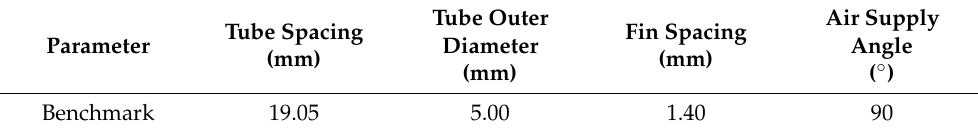
Table 7. Benchmark parameter values in the simulation.